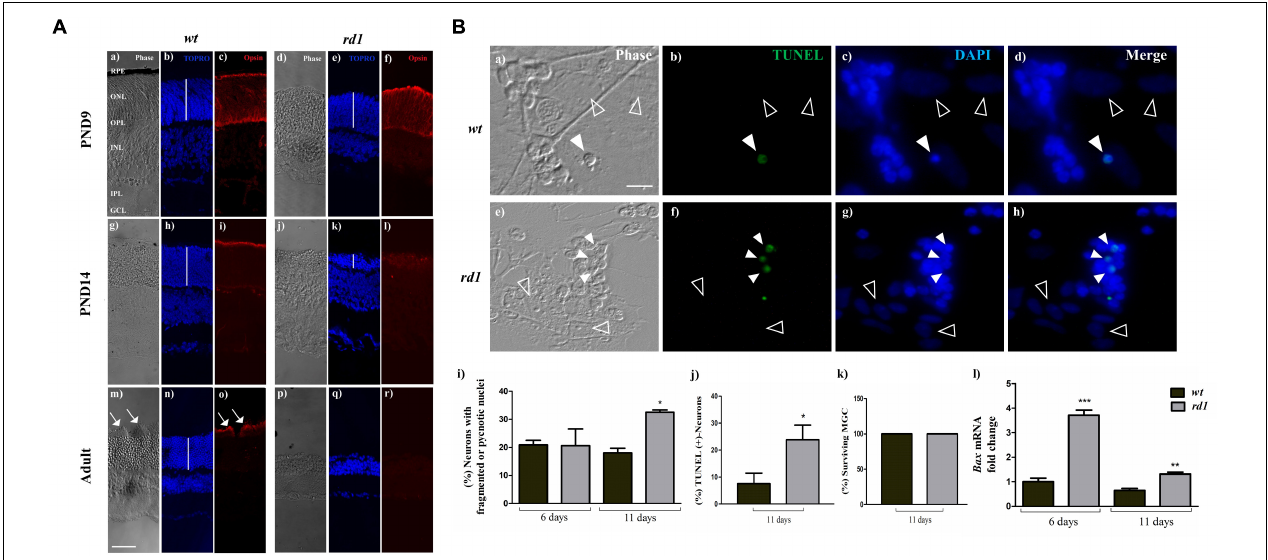
FIGURE 2 | Selective degeneration of photoreceptors in the rd1 mice retina and in mixed rd1 neuron-glial cultures. Panel (A) phase (a,d,g,j,m,p) and fluorescence (b,c,e,f,h,i,k,l,n,o,q,r) photomicrographs of retinal cryosections from wt PND 9 (a–c) , PND 14 (g–i) and Adult ( m–o , PND30); and rd1 PND 9 (d–f) , PND 14 (j–l), and Adult (p–r) . Photoreceptors were labeled with an anti-opsin, Rho4-D2, antibody (c,f,i,l,o,r) and cell nuclei were stained with the nuclear probe TOPRO-3 (b,e,h,k,n,q) . White vertical bars show the thickness of the Outer Nuclear Layer (ONL) in wt and rd1 retinas. Opsin immunolabeling was evident in wt and rd1 retinas at PND 9 (c,f) , and concentrated in photoreceptor outer segments of wt retinas at PND 14 and 30 (i,o) ; in contrast, it was barely visible in rd1 retinas at PND 14 (l) and completely disappeared by PND 30 (r) . White arrows in (m,o) show outer segments in wt photoreceptors at PND 30. Panel (B) phase (a,e) and fluorescence (b–d,f–h) photomicrographs of mixed neuron-glial cultures from wt (a–d) and rd1 (e–h) mice after 11 days in culture showing apoptotic neurons (white arrowheads) detected by TUNEL labeling (b,f) . Nuclei were stained with DAPI (c,g). Note that MGC nuclei (empty arrowheads in a–h ) remained intact in wt and rd1 cultures. Bars in (i) show the percentage of neurons with fragmented or pyknotic nuclei, (j) depict the percentage of TUNEL-positive neurons, (k) show the percentage of surviving MGC and (l) represent the fold-change in Bax mRNA levels relative to these levels in wt cultures at day 6. In Panel (A) scale bar: 50 µ m. In Panel (B) scale bar: 5 µ m. Results represent the mean ± SEM of three experiments ( n = 3). Statistical analysis was performed using a two-tailed Student t -test [Panel (B) j,k ] and a One-way ANOVA with a post hoc Tukey test [Panel (B) i,l ]. ∗ p < 0.05, ∗∗ p < 0.01, ∗∗∗ p < 0.001.